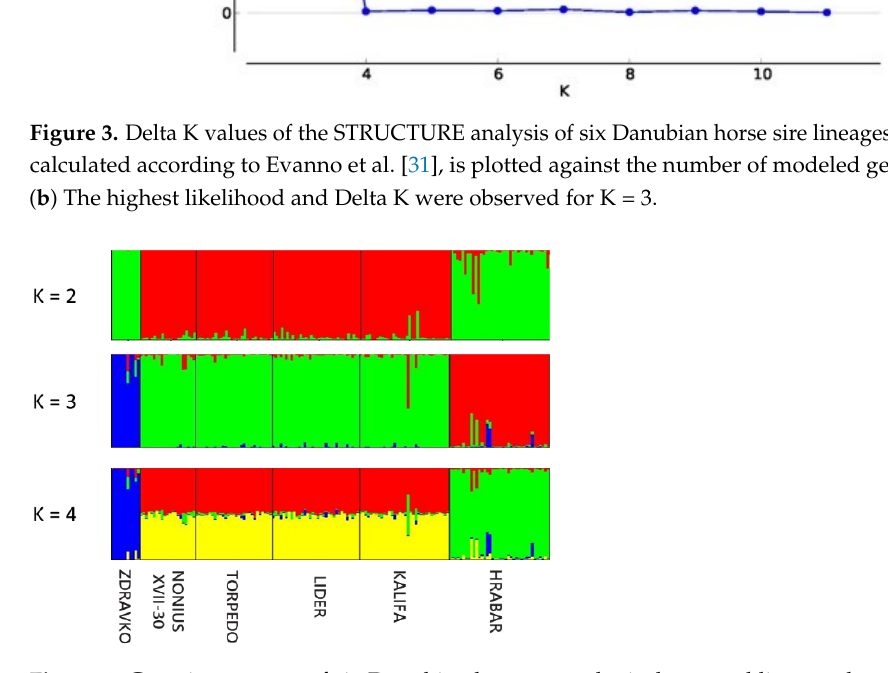
Figure 4. Genetic structure of six Danubian horse genealogical paternal lineages based on 15 SSR marker data. The clustering assignment depended on the Bayesian method under an admixture model obtained with STRUCTURE software. Each individual is represented by a single column that is divided into segments whose size and color correspond to the relative proportion of the animal genome corresponding to a particular cluster.